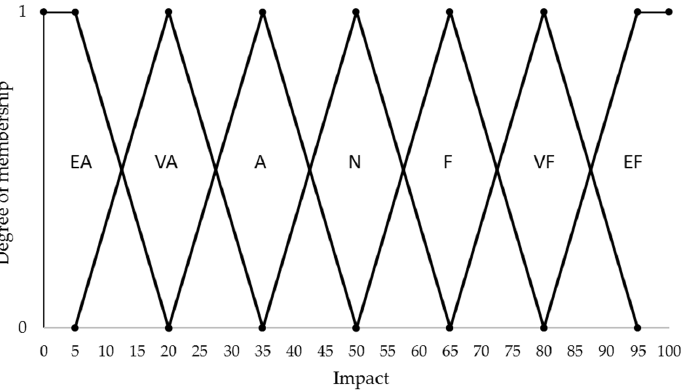
Figure 1. Fuzzy set for the impact of a machining control parameter on a sustainability measure.